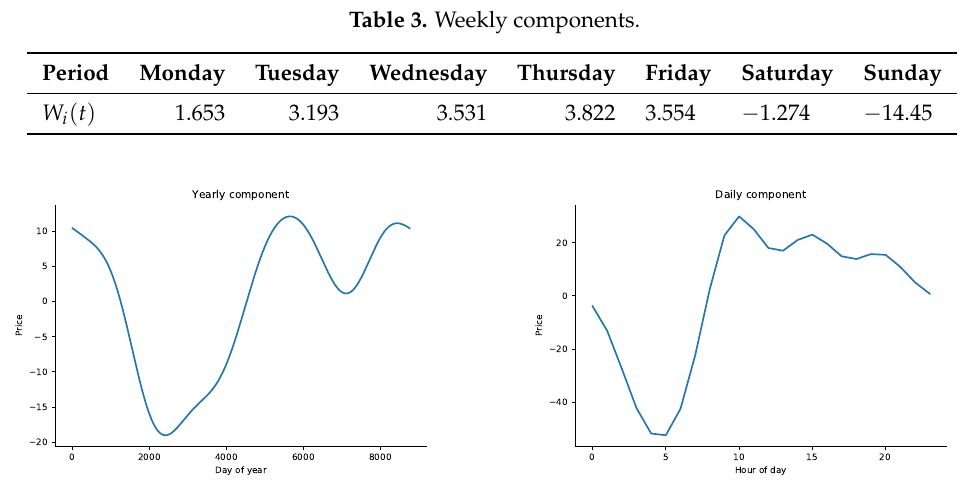
Figure 6. Seasonal components for yearly and daily